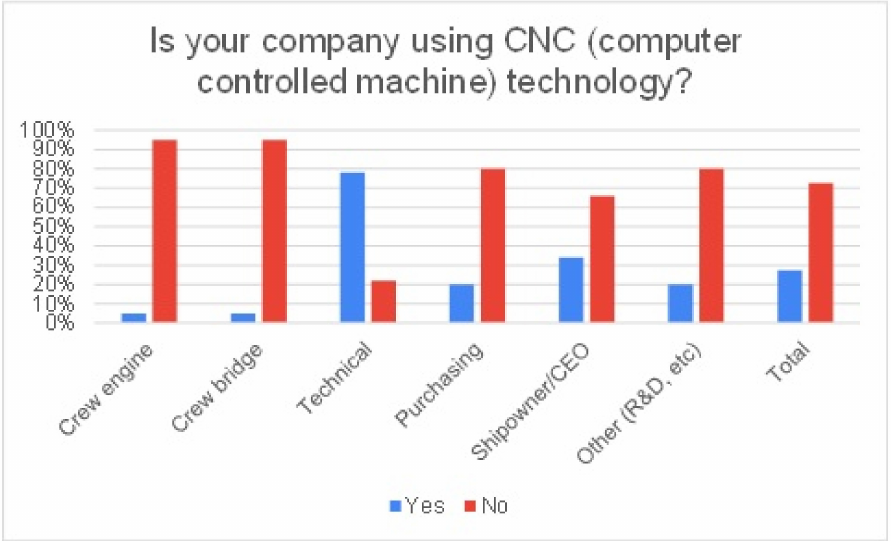
Figure 10. Use of CNC technology.